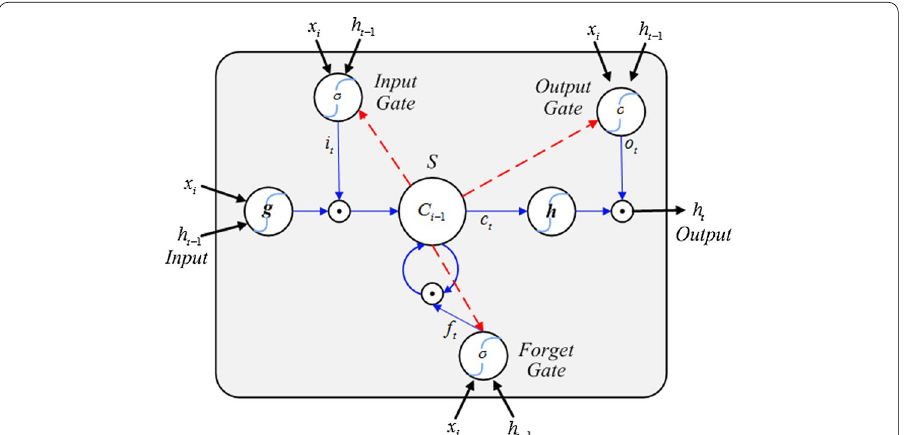
Fig. 3 Network architecture of the LSTM